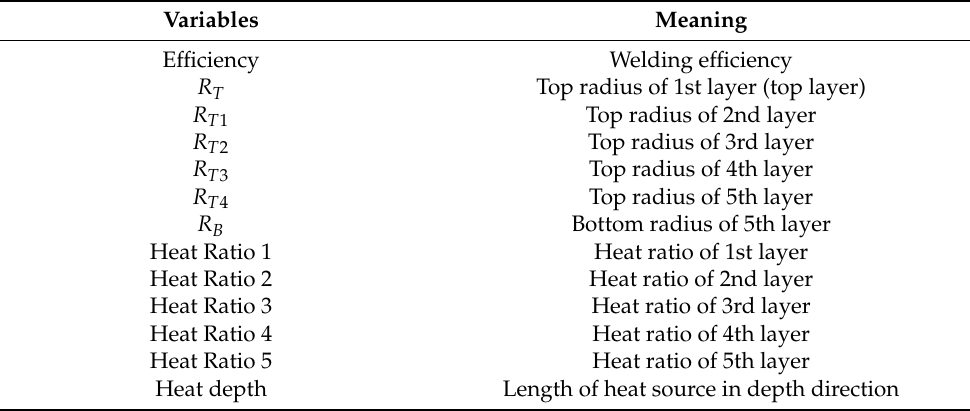
Table 2. Variables of heat source model.